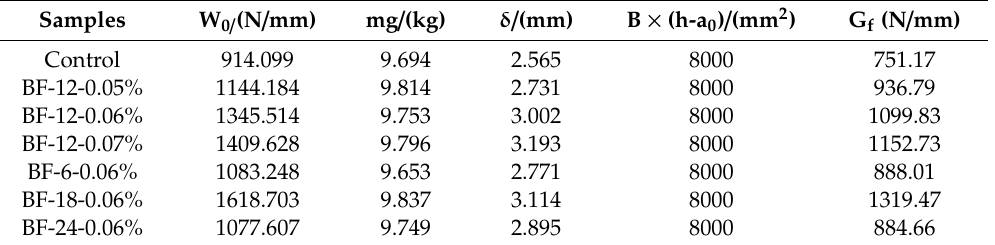
Figure 12. CMOD curve of BFRCs with different ( a ) BF content; ( b ) BF length. Table 7. Fracture parameters of BFRCs.